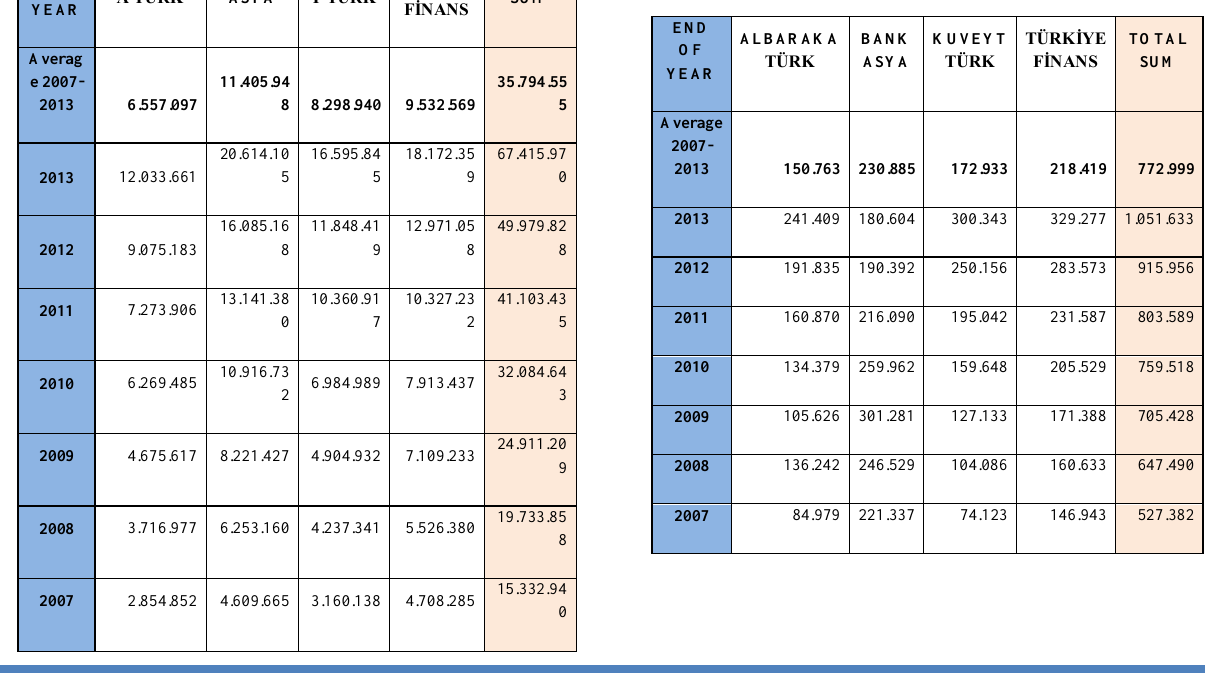
Table-12/a:Growth of Net Profit, 2007-2013